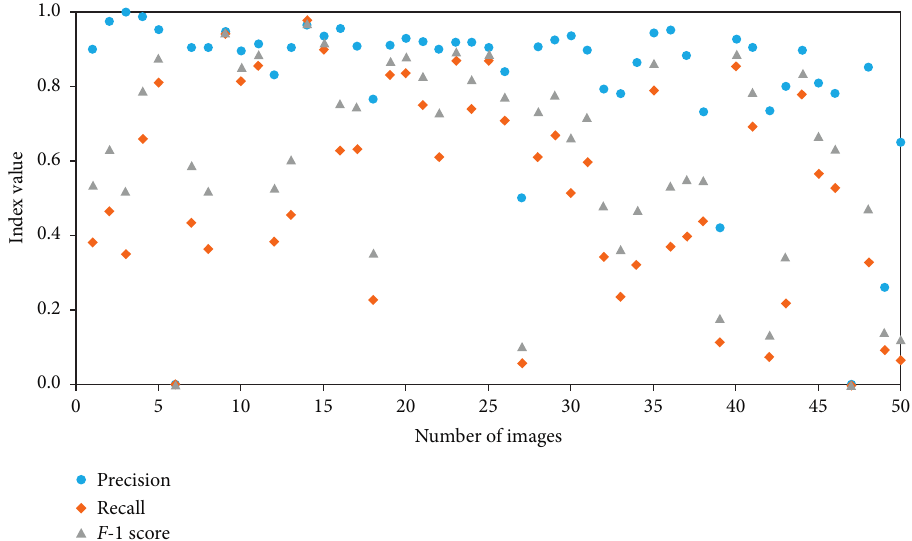
Figure 31: Three evaluation indexes of 50 images from the 200-dataset using the cubic